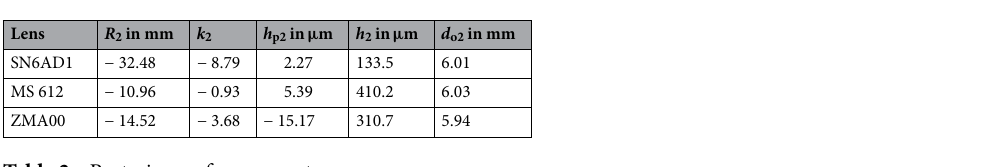
Table 2. Posterior surface geometry.